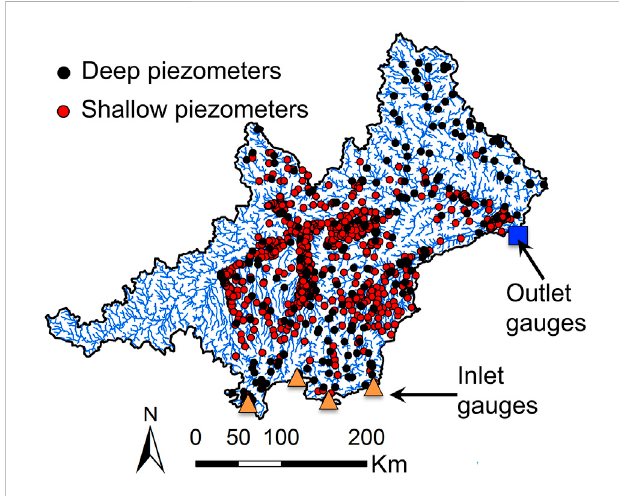
FIGURE 2 Position of available observation points at the modeled area and inlet and outlet gauging stations used for the hydrological model